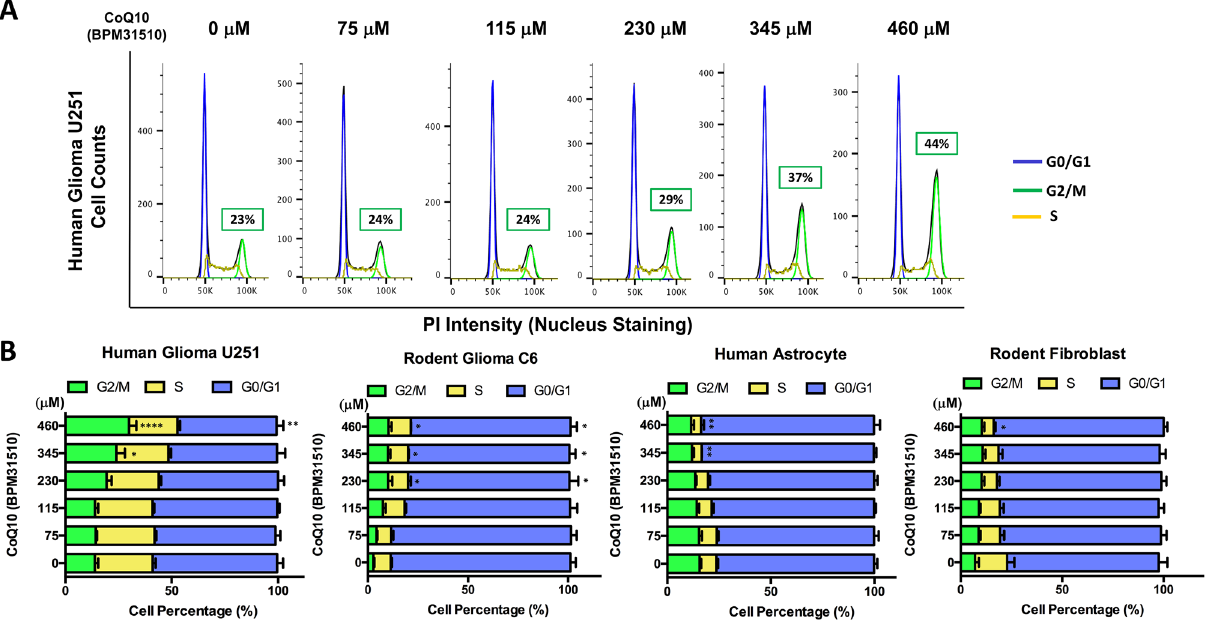
Figure 2. Ubidecarenone induces G 2 /M cell-cycle arrest of glioblastoma but not non-cancerous cell lines. ( A ) Cell cycle analysis and quantification of human U251 glioma cells treated with 0, 75, 115, 230, 345, or 460 µM ubidecarenone. The percentage of cells in each phase (G 0/1 , S or G 2 + M) is estimated from the frequency histograms. The percentage of cells in G 2 + M phase is highlighted. ( B ) Quantification of human U251 glioma, rat C6 glioma, HA, or mouse NIH3T3 fibroblast cells in each cell phase. All data presented as mean ± SEM. *P < 0.05, **P < 0.01, ***P < 0.001, ****P < 0.0001 compared to control (no drug exposure) at the same cell cycle